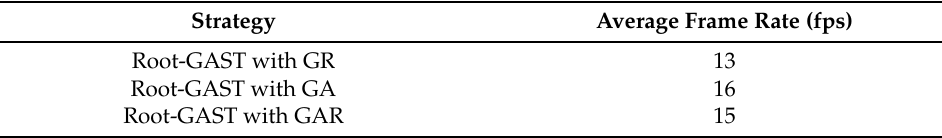
Table 7. Frame rate per